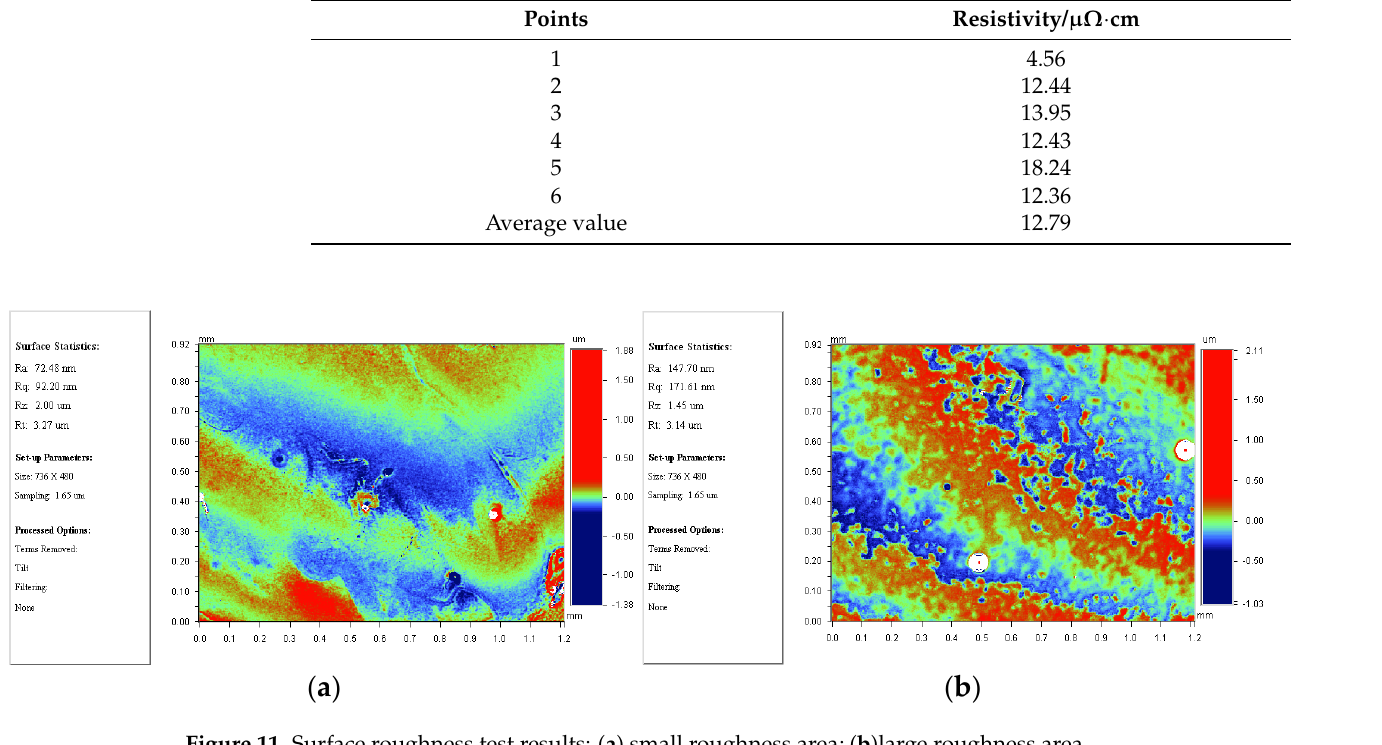
Figure 11. Surface roughness test results: ( a ) small roughness area; ( b )large roughness area. Table 3. Resistivity test results.